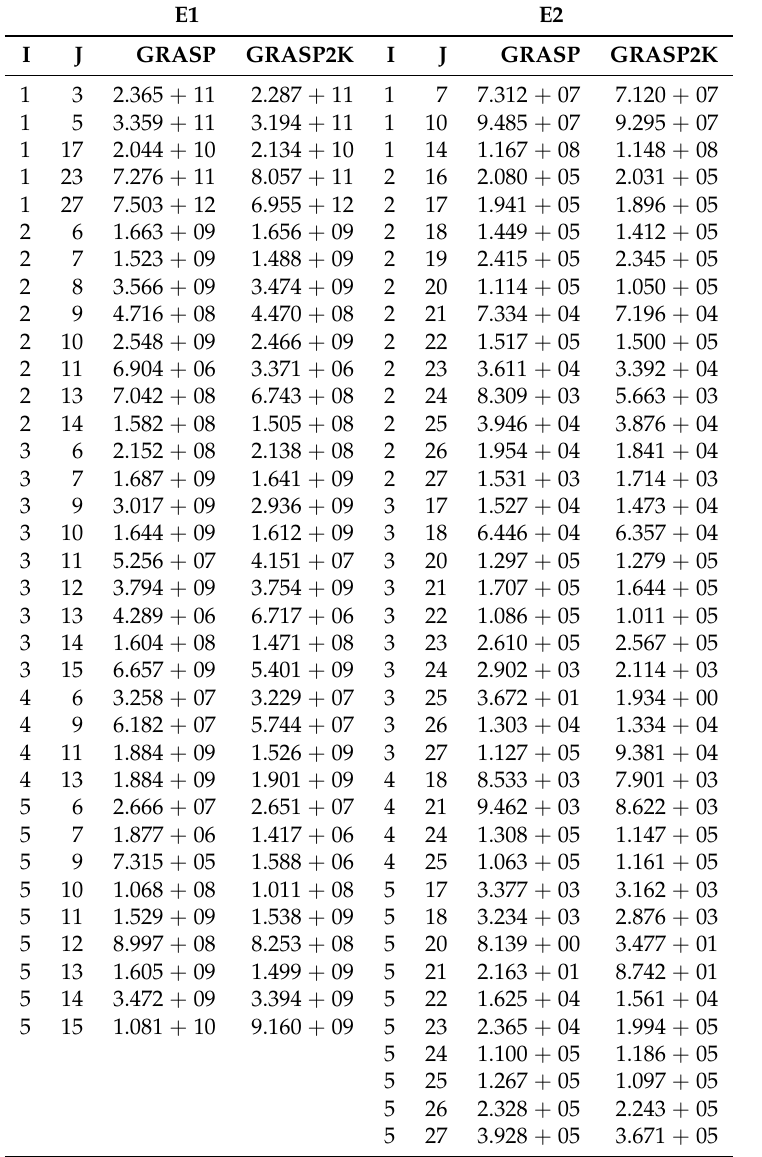
Table 9. Comparison of A -values (s − 1 ) for some E1 and E2 transitions of Sc XII. a ± b ≡ a × 10 ± b